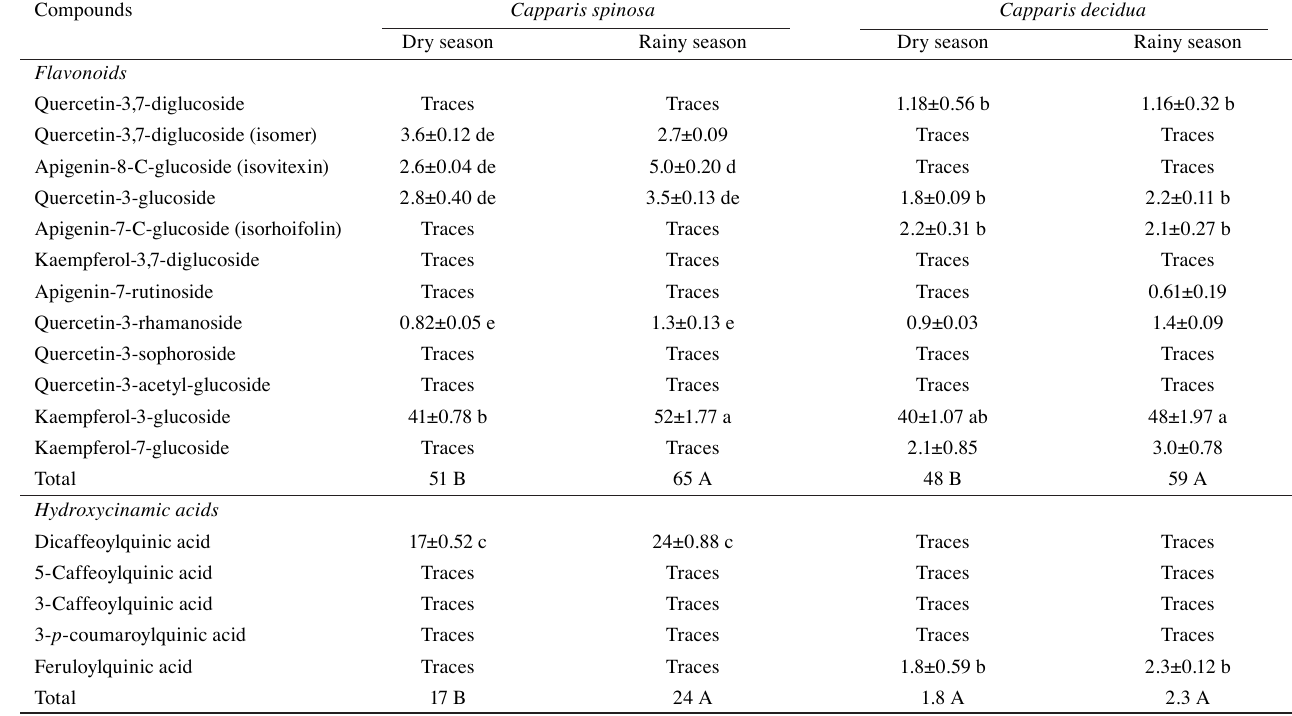
Tab. 4: Identification and quantification of phenolic acids and flavonoids (μg g -1 dw) in flower of C. spinosa and Capparis decidua